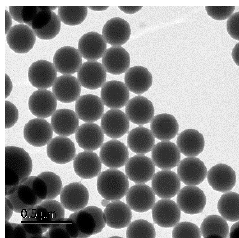
Figure 2. TEM image of a two-dimensional array formed from 5% emulsion.